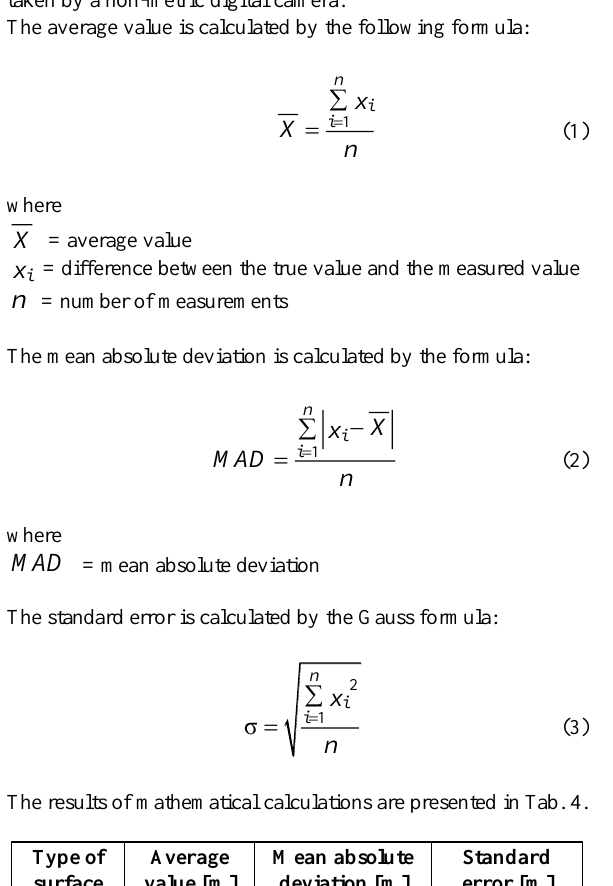
Figure 7. Point distribution across the façade Standard formulas used for mathematical processing of geodetic measurements (Rusyaeva, 2016) were applied to determine the accuracy of three-dimensional model creation from images taken by a non-metric digital camera.